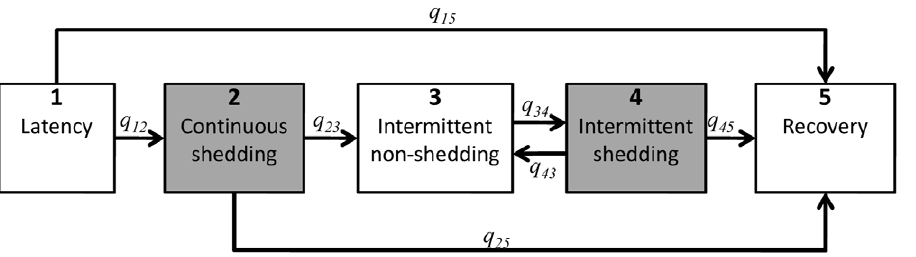
Figure 1. A multistate model describing transition of pigs through the states of shedding following challenge. At time t an individual is in state i . Its 5 states are labeled 1, 2, 3, 4, and 5, denoting: 1-latency: the individual has been challenged but has not yet started (or will never start) shedding; 2-continuous shedding state; 3-intermittent non-shedding state; 4-intermittent shedding state; and 5-recovery: clearance of Salmonella from feces. Gray shaded compartments denote the pigs that excrete detectable levels of Salmonella in feces.